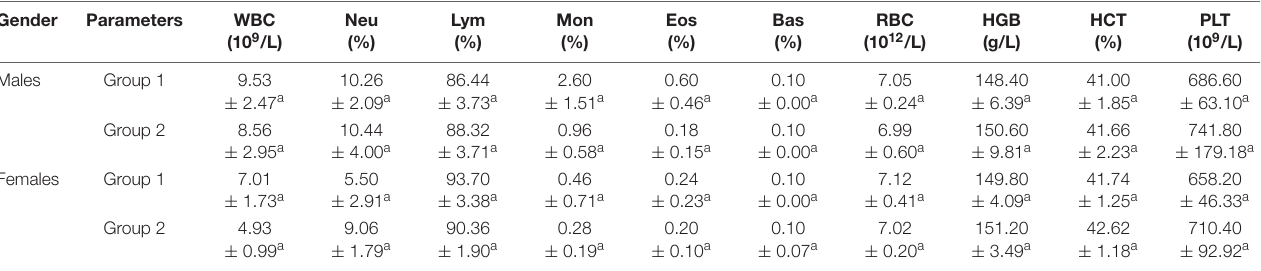
TABLE 4 | The hematological parameters analysis of control group and rats treated with the crude enzymes for 28